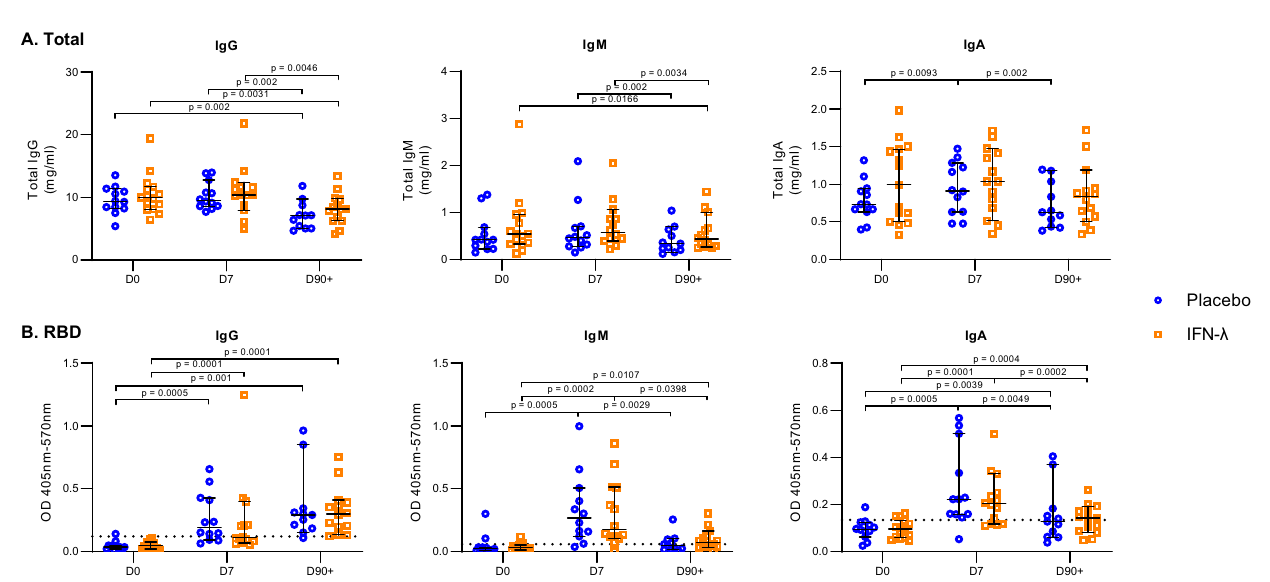
Fig. 2 | Comparisonoftotaland SARS-CoV-2 spike-RBD plasma antibody levels between placebo and PEG-IFN- λ treated patients at day 0, day 7, and day 90+post-enrollment. A , B Total IgG, IgM and IgA ( A ) and RBD-speci fi c IgG, IgM andIgA( B )inpatientplasmaweremeasuredbyELISAfromsamplescollectedday0 (D0), day 7 (D7) and day 90+(D90+) post enrollment in the phase II clinical trial. Dashed line in ( B ) represents the mean+2SD of results obtained from 8 pre-